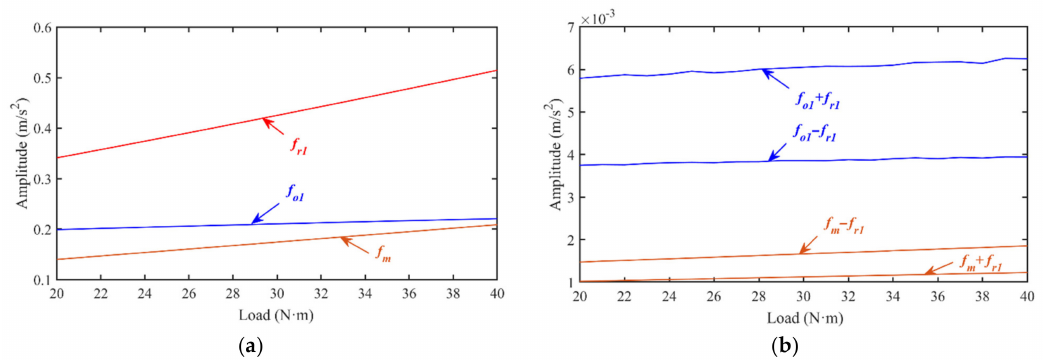
Figure 13. Indicators for vibration characteristics of the bearing-rotor-gear system at different loads: ( a ) amplitudes of f r 1 , f o 1, and f m ; ( b ) amplitudes of f o 1 ± f r 1 and f m ± f r 1